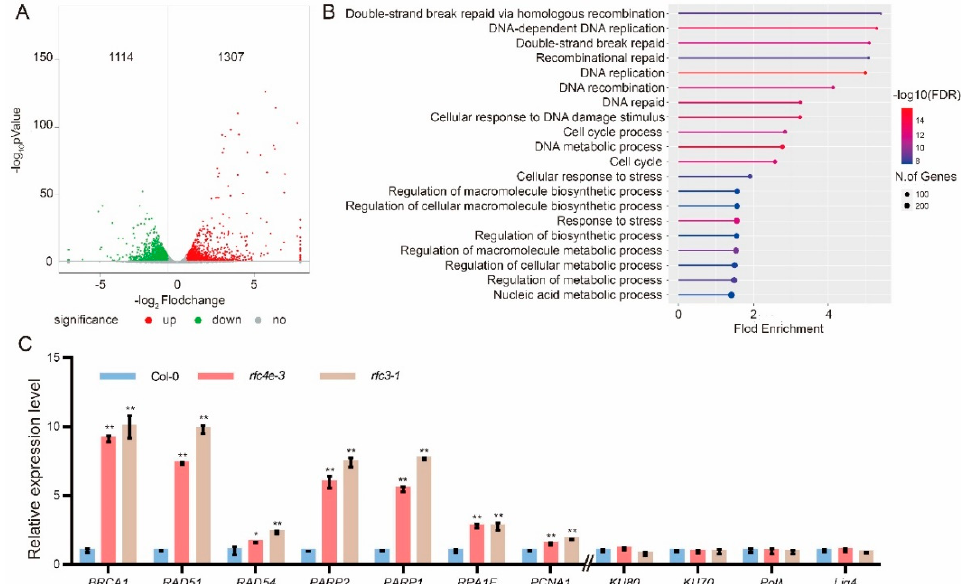
Figure 3. The whole transcriptome of the rfc4e − 3 mutant reveals overexpression of numerous DDR genes. ( A ) Volcano plots showing the differentially expressed genes in rfc4e − 3 compared with wild- type plants ( p < 0.05, |Log2FoldChange| ≥ 0.58). The red dots represent significantly upregulated genes, and the green dots represent significantly downregulated genes. ( B ) Gene Ontology (GO) enrichment analysis of the 1307 upregulated genes. The size of each dot represents the gene count, and the color of each dot represents the enrichment fold. ( C ) Relative expression levels of gene transcripts from 12 − d − old in vitro-grown plants of the indicated genotype as determined by RT-qPCR. The expression level in Col − 0 was used as a standard for normalization control. Data are means of triplicate technical repetitions from one of three biologically independent experiments. Error bars indicate ± SD (* p < 0.05; ** p < 0.01).